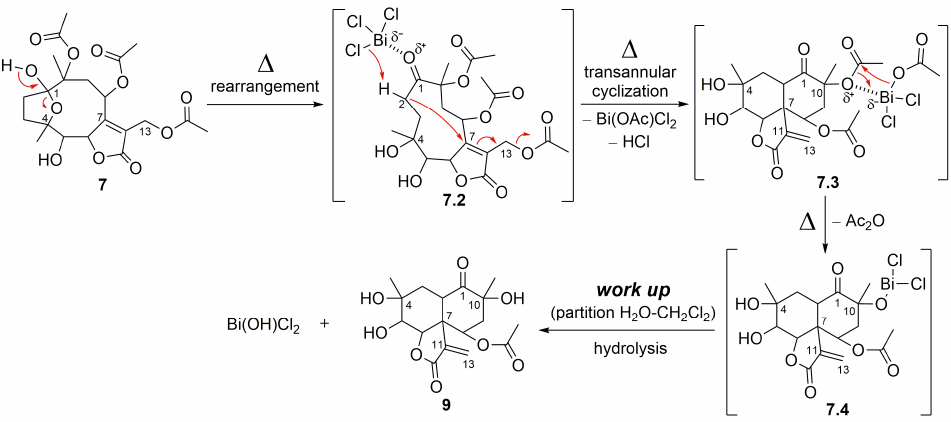
Figure 9. Proposed mechanism for the formation of SL semisynthetic derivative 9 (red arrows illustrate the arrow-pushing mechanism). illustrate the arrow-pushing